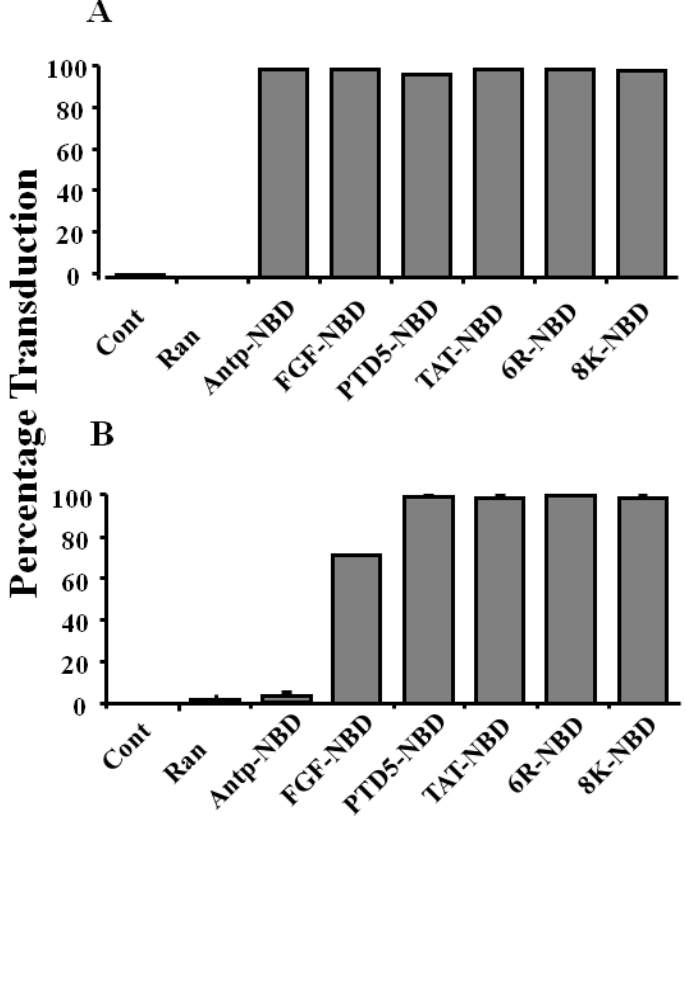
Figure 2. Transduction efficiency of PTD-NBD peptides. Figure showing FACs analysis of HeLa cells after 1 h of incubation with 6CF control peptide (random) or 6CF-PTD-NBD peptides. Cells were treated for 1 h with either 10 or 100 µM of fusion peptides as indicated. Cells positive for 6CF were analyzed and the % of positive cells graphed (Panels A and B). Cytoxicity of PTD-NBD peptides. HeLa cells were incubated with varying concentrations of PTD-NBD peptides, after 3 h incubation, cells were washed, evaluated by microscopy (Panel C) and viability was determined by MTT assay (panel C bar diagram; panel D). # P <